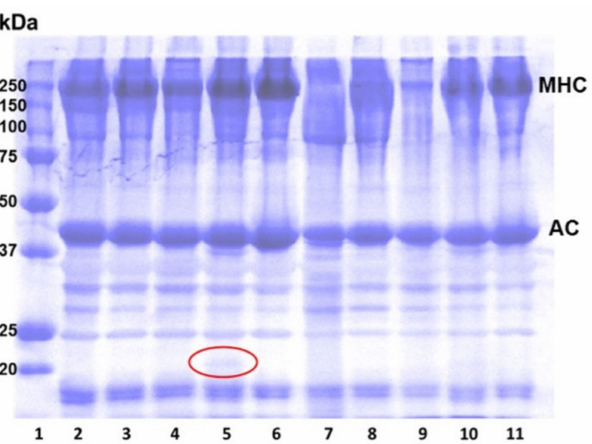
Figure 2. SDS-PAGE patterns of Pacific whiting surimi gels without and with 2% inhibitors. Lane 1, protein marker; Lane 2–6, the gels heated to 90 ◦ C directly; Lane 7–11, the gels held at 60 ◦ C prior to heating to 90 ◦ C. Lane 2 and 7, control; Lane 3 and 8, PE; Lane 4 and 9, FD-PFJ; Lane 5 and 10, PPI; Lane 6 and 11, EW; MHC, myosin heavy chain; AC,